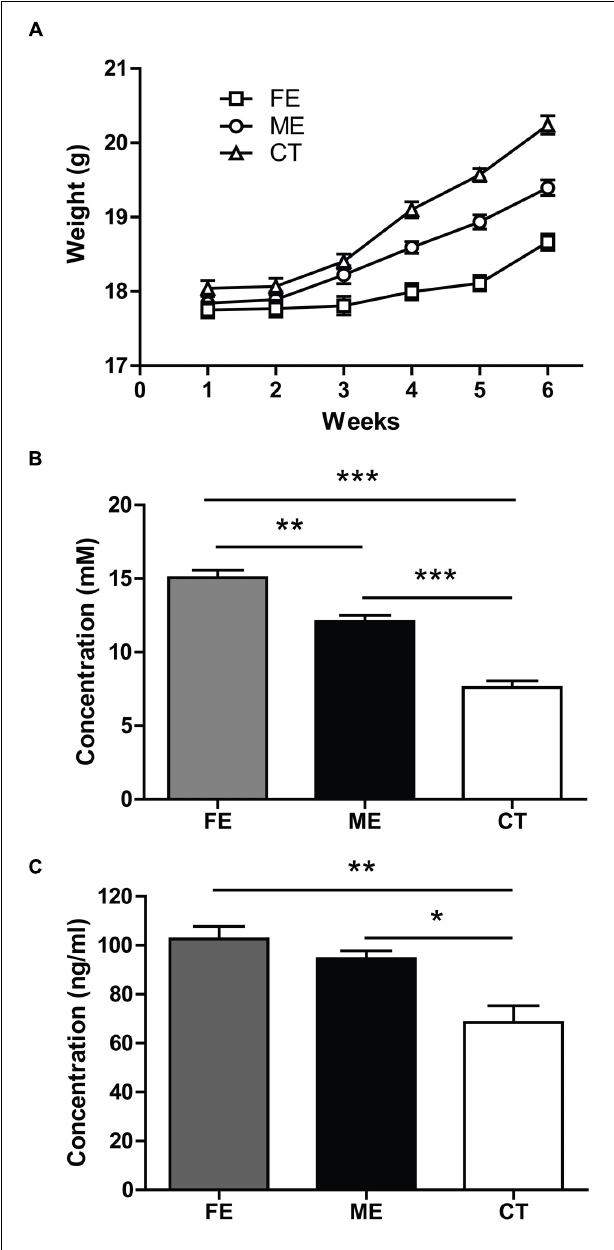
FIGURE 1 | Parameters indicating different exercise intensities. (A) After 6 weeks of forced treadmill running, the fatiguing exercise (FE) group weighs less than the moderate exercise (ME) group, while the ME group weighs less than the control (CT) group. Two-way ANOVA, F 2 , 72 = 37.69, P < 0.0001; post hoc test: ME vs. CT: P < 0.001; FE vs. CT: P < 0.0001; ME vs. FE: P < 0.0001; n = 25 in each group. (B) Following the last treadmill running session, blood lactate levels in FE mice are significantly higher than those in the ME mice, and blood lactate levels in ME mice are significantly higher than those in CT mice. One-way ANOVA, F 2 , 12 = 68.40, P < 0.0001; post hoc test: ME vs. CT: ∗∗∗ P < 0.001; FE vs. CT: ∗∗∗ P < 0.001; ME vs. FE: ∗∗ P < 0.01; n = 5 in each group. (C) Concentrations of serum cortisol in FE or ME mice are significantly higher than those in the CT mice. There is no significant difference between the FE and ME groups. One-way ANOVA, F 2 , 12 = 11.52, P = 0.0016; post hoc test: ME vs. CT: ∗ P < 0.05; FE vs. CT: ∗∗ P < 0.01; FE vs. ME: P > 0.05; n = 5 in each